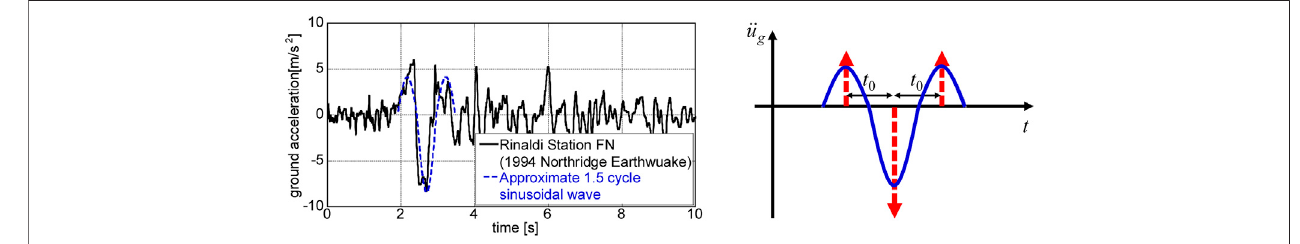
FIGURE2| Comparisonofnewmethodofinputtransformationwithconventionalmethodofoscillatingmodeltransformation. (A) Conventionalmethod:equivalent linearization of oscillating model for unchanged input, (B) New method: transformation of input into triple impulse for unchanged oscillating model.